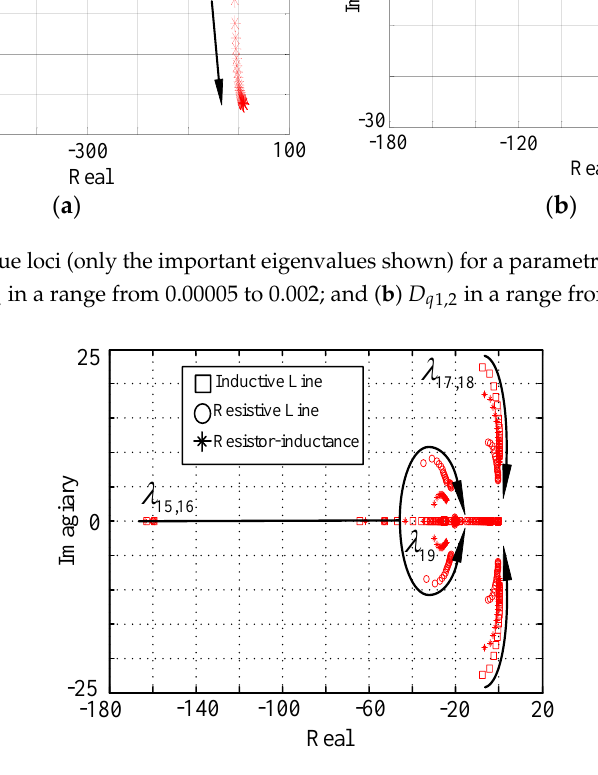
Figure 13. Eigenvalue loci for a parametric sweep of the inertia J. Table 3. The system eigenvalues.